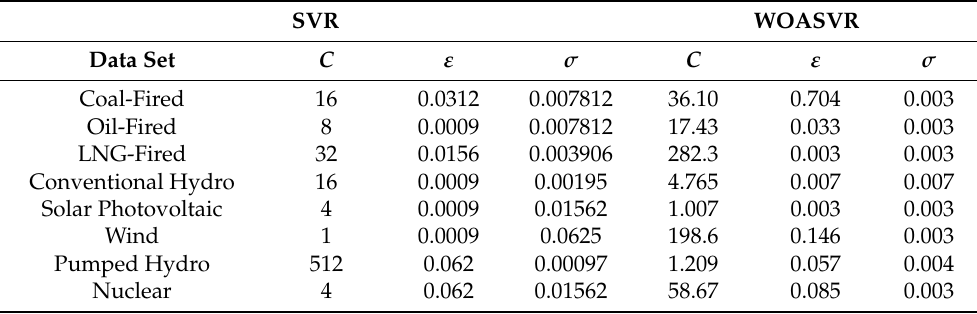
Table 3. Training results obtained with support vector regression (SVR) and whale-optimization- algorithm-based SVR (WOASVR) under different parameter